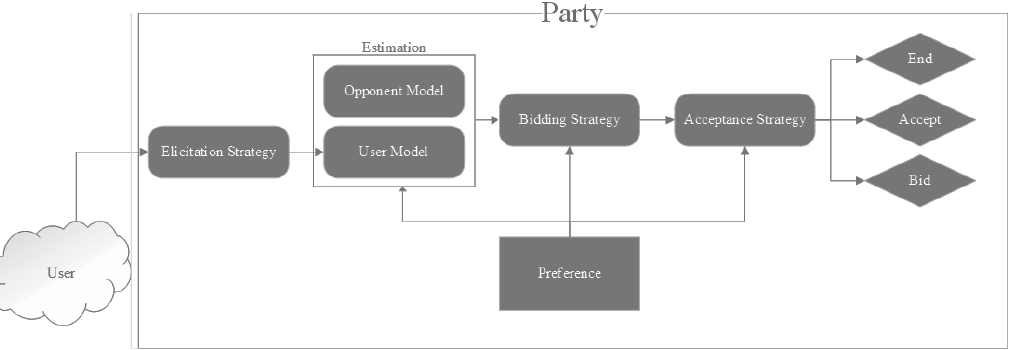
Figure 3. In the EUBOA framework, each agent has four components: elicitation strategy elicits user preferences; user modeling constructs a model of user preferences; opponent modeling makes a model of opponent preferences; bidding strategy decides which bid should be sent to the opponent, and acceptance strategy decides whether or not to accept the opponent’s offer.